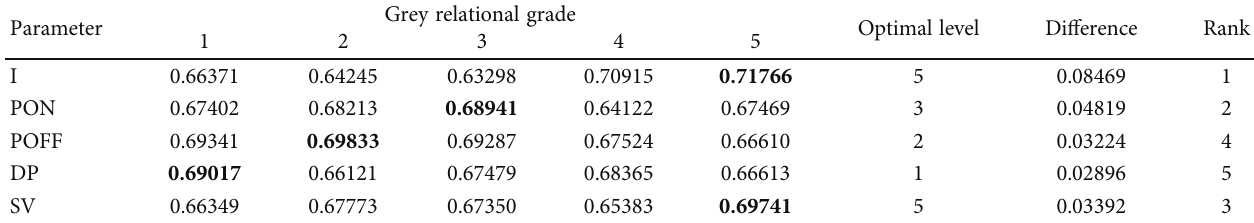
Table 5: Factor e ff ect on